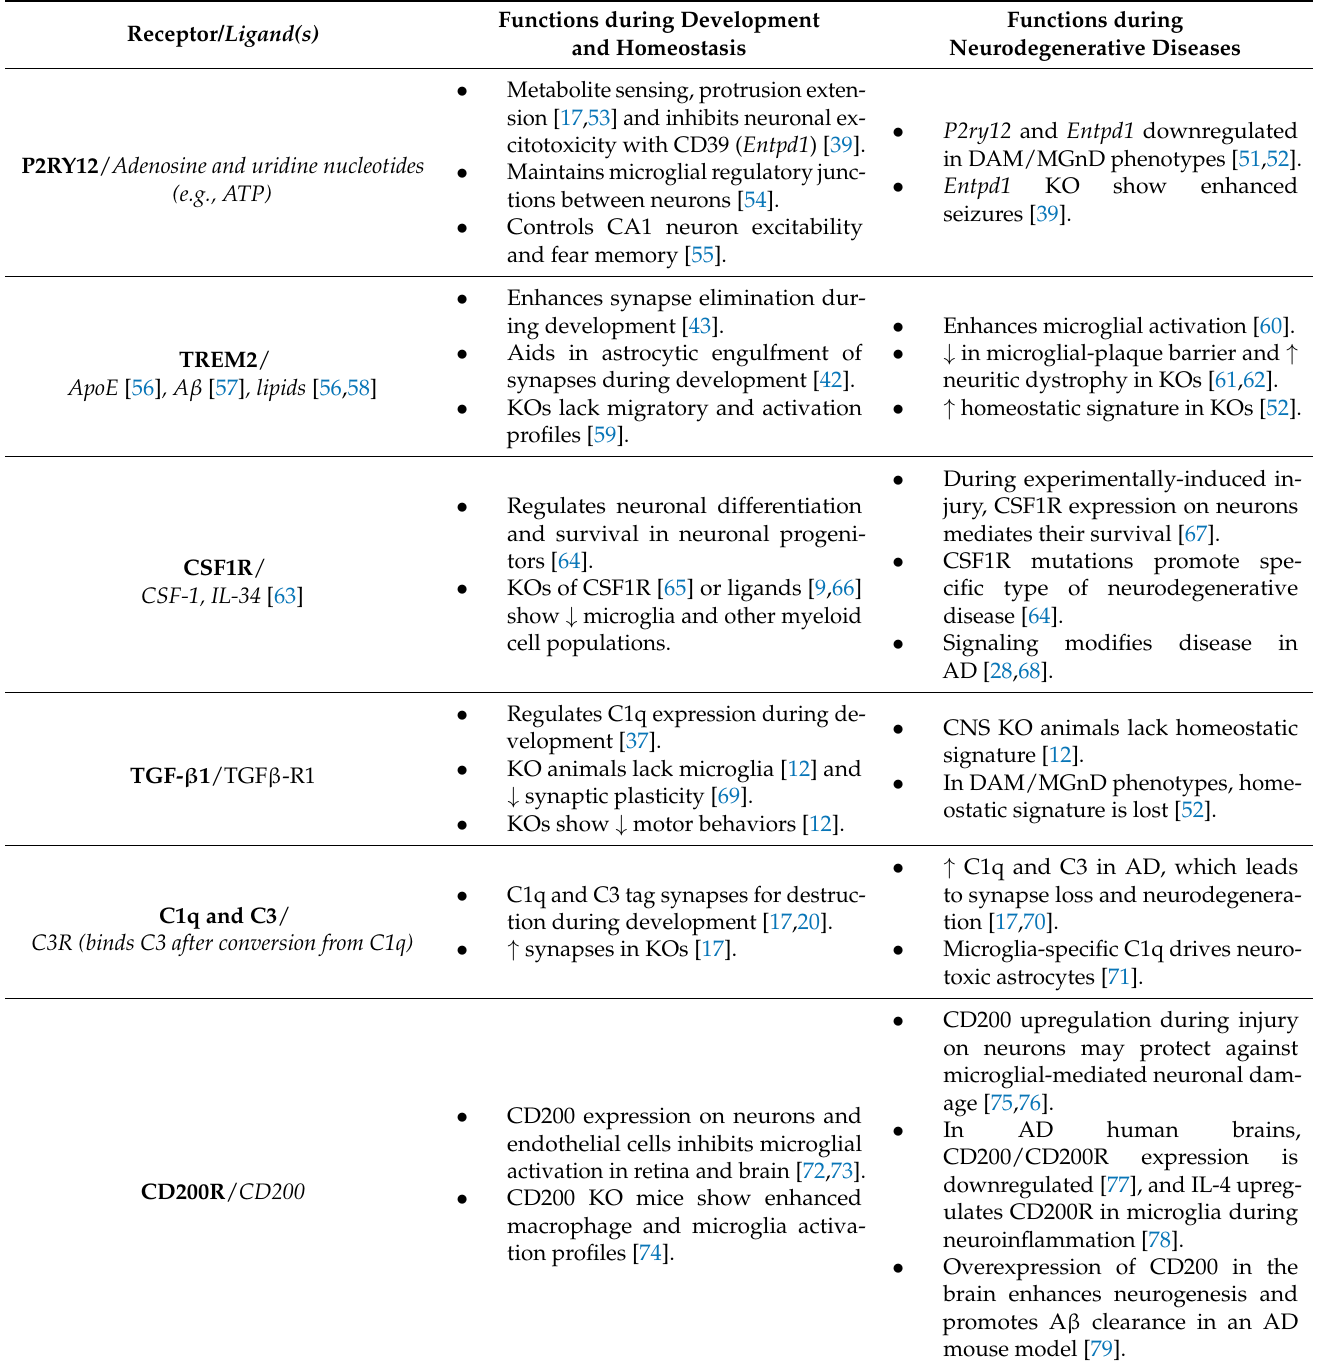
Functions during Neurodegenerative